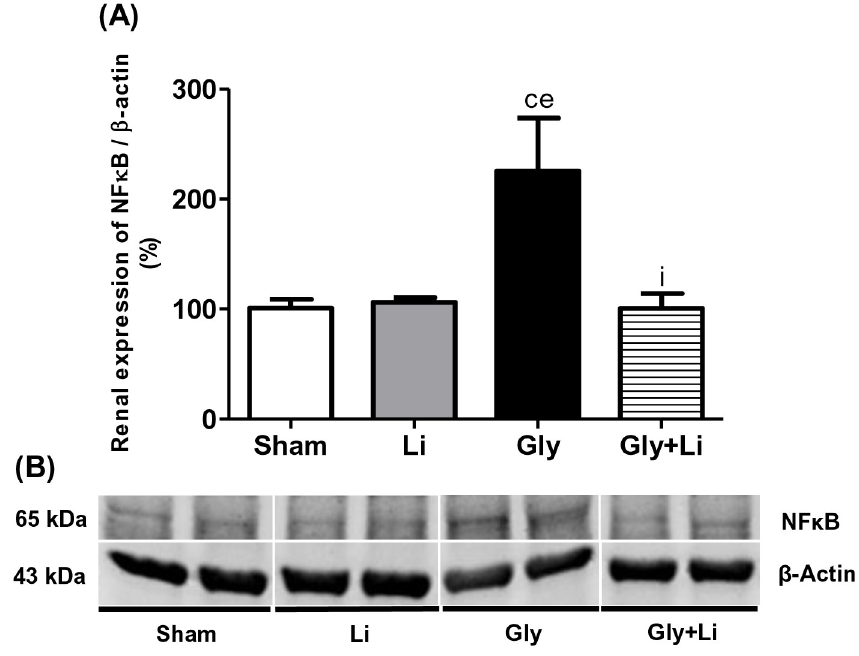
Fig 4. Semiquantitative immunoblotting for NF κ B expression in rat kidney tissue. (A) NF κ B densitometric analysis of kidney samples from Sham, Li, Gly and Gly+Li rats. (B) Representative immunoblots which reacted with anti-NF κ B revealing bands of 65kDa. Values are means ± SEM. c p < 0.05 vs. Sham; e p < 0.01 vs. Li; i p < 0.05 vs. Gly. Li, lithium; Gly, glycerol; Gly+Li, glycerol +